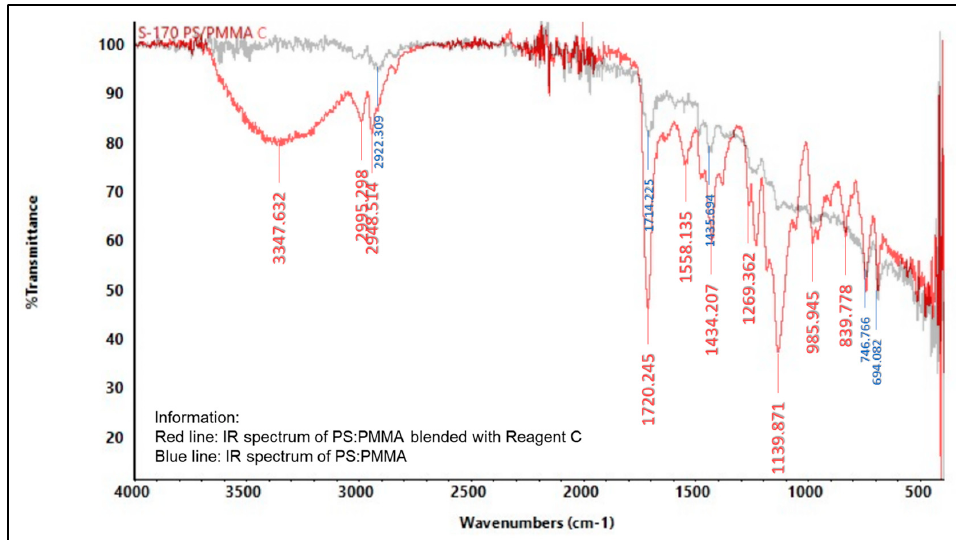
Figure 9. IR spectrum comparison of pure PS:PMMA and blended PMMA with reagent C (10% NaOH).